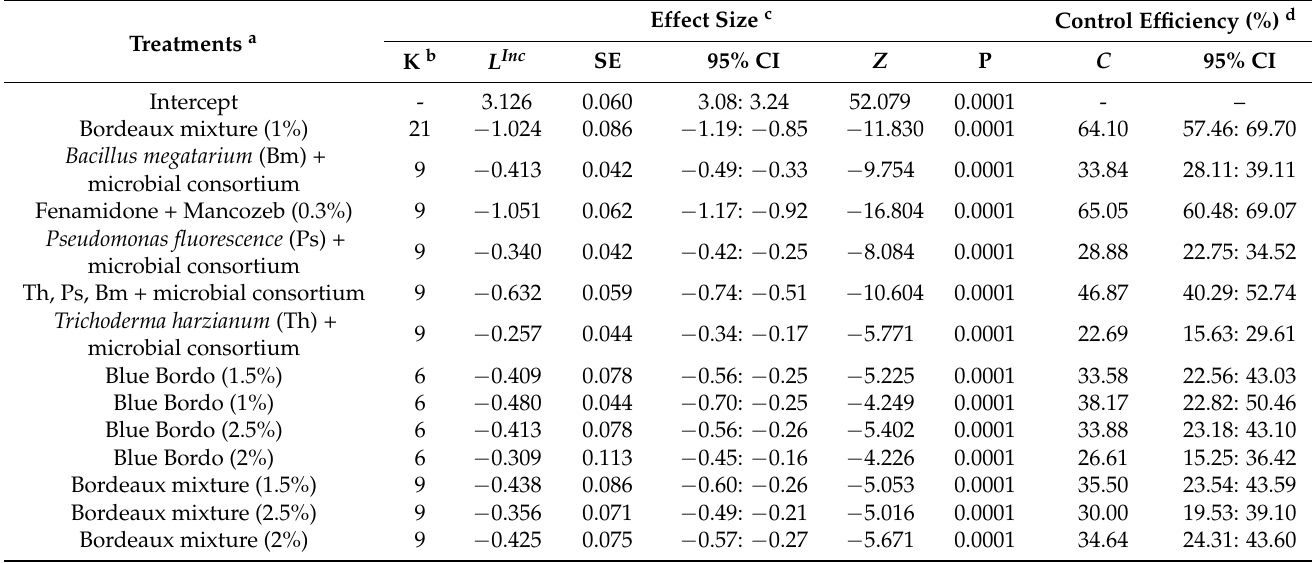
Table 4. Estimated response rates for FRD ( DP Low > 35%) for each treatment compared to the untreated check as determined via the network meta-analytical model. Percentages of control efficiency and corresponding model statistics are